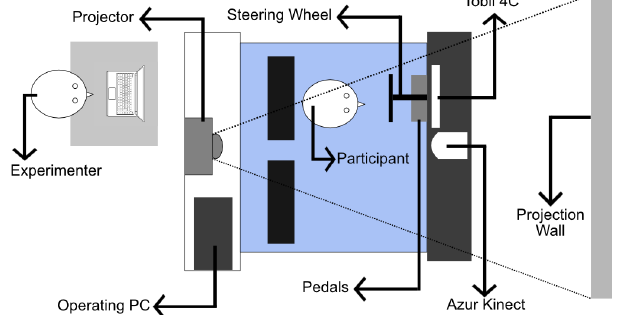
Figure 1. Schematic representation of the technical setup in the driving